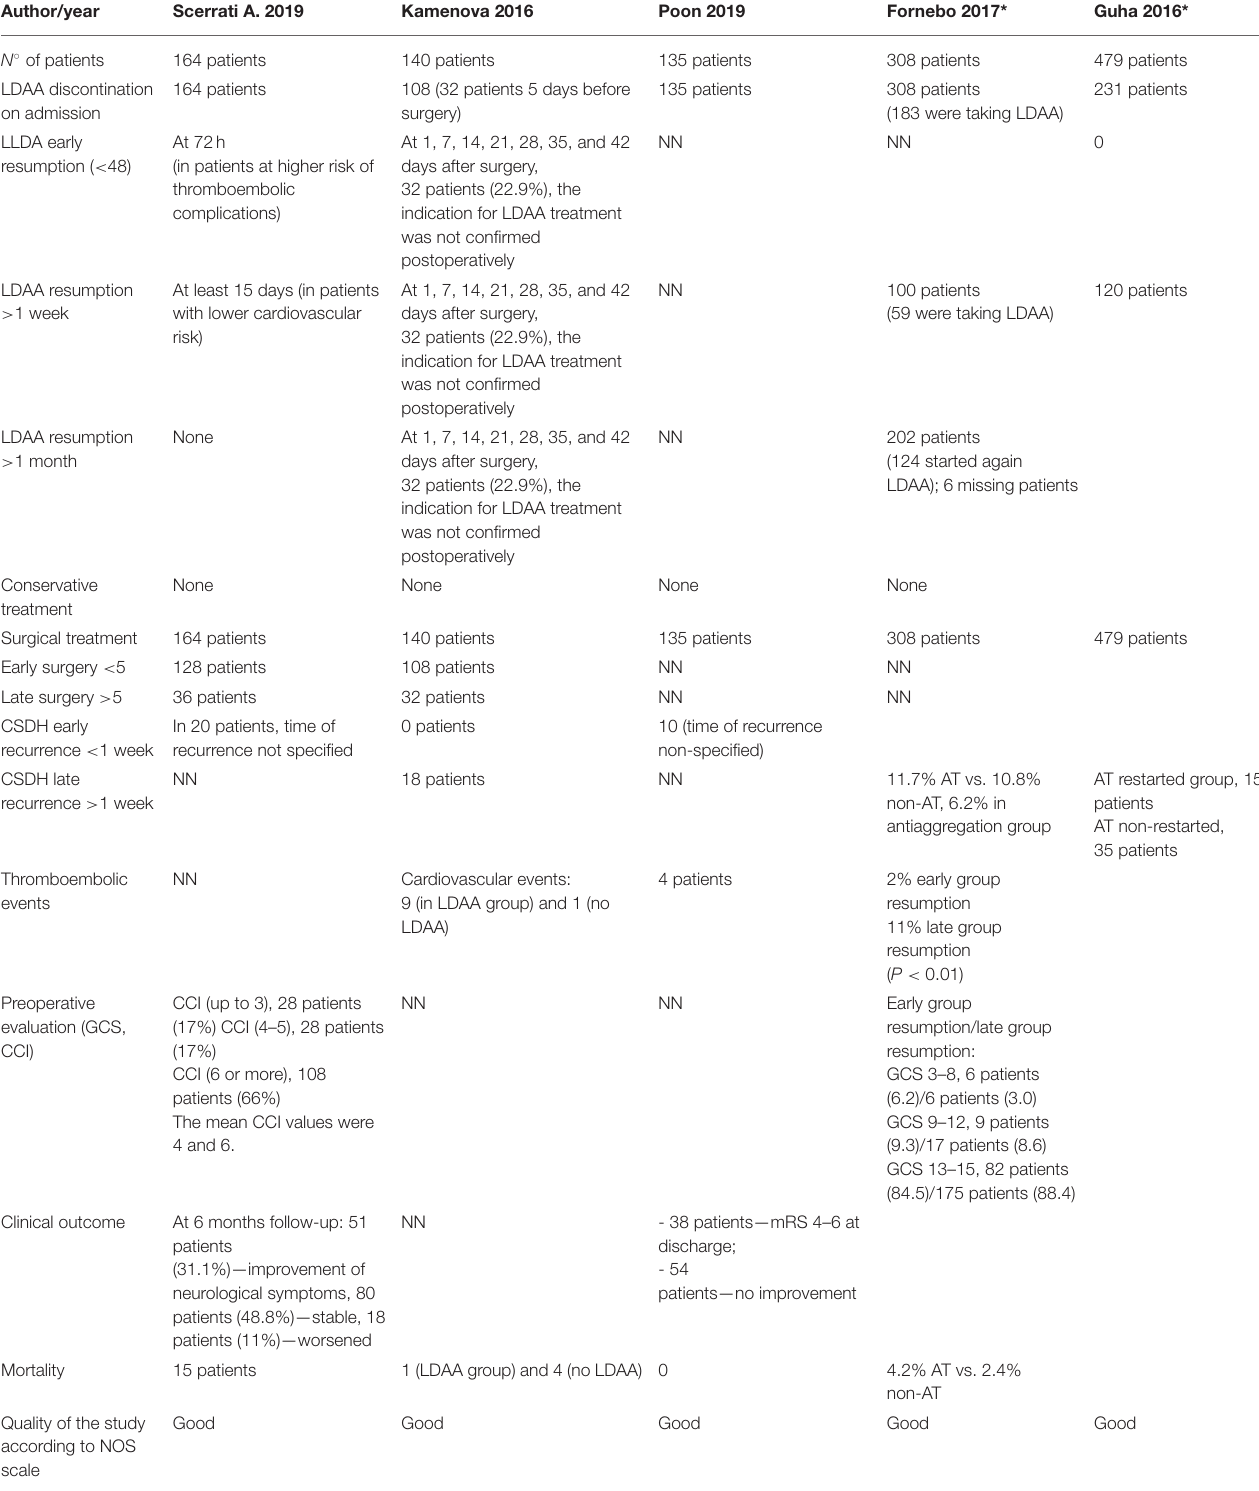
TABLE 1 | Collected studies and data